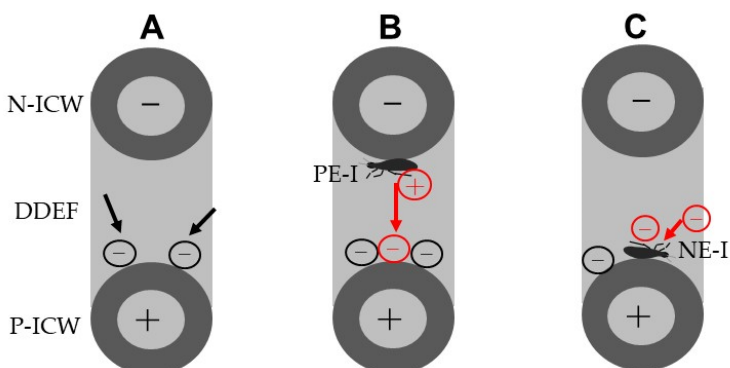
Figure 15. Schematic representation of the insect capture mechanism of the DD screen. ( A ) DDEF produced by two oppositely charged insulated conductor wires. Free electrons in the air are attracted to the positive pole. ( B ) Insect capture by the negative pole. The insect was positively electrified by discharge-mediated positive electrification and then attracted to the negative pole. Free electrons (red arrow) in the insect were released and attracted to the positive pole. ( C ) Insect capture by the positive pole. The insect was negatively electrified by free electrons around the positive pole and then attracted to the positive pole (charge-mediated negative electrification). N-ICW, negatively charged insulated conductor wire; P-ICW, positively charged insulated conductor wire; DDEF, double-charged dipolar electric field; PE-I, positively electrified insect; NE-I, negatively electrified insect [39].